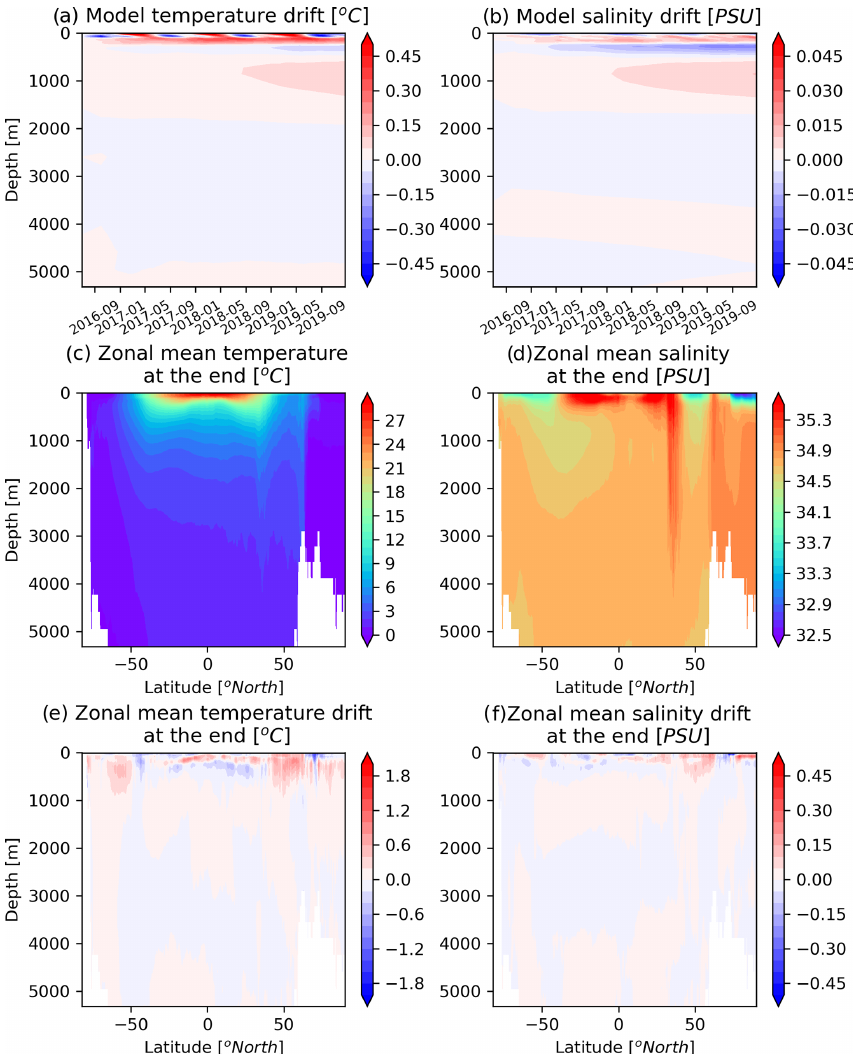
Figure A2. Model drift of temperature (a) and salinity (b) , zonally averaged temperature (c) , salinity (d) , and the corresponding drift (e, f) at the end of EXP1. As the last day of model integration is 31 December 2019, the drifts in (e) and (f) are calculated using the simulation difference between December 2016 and December